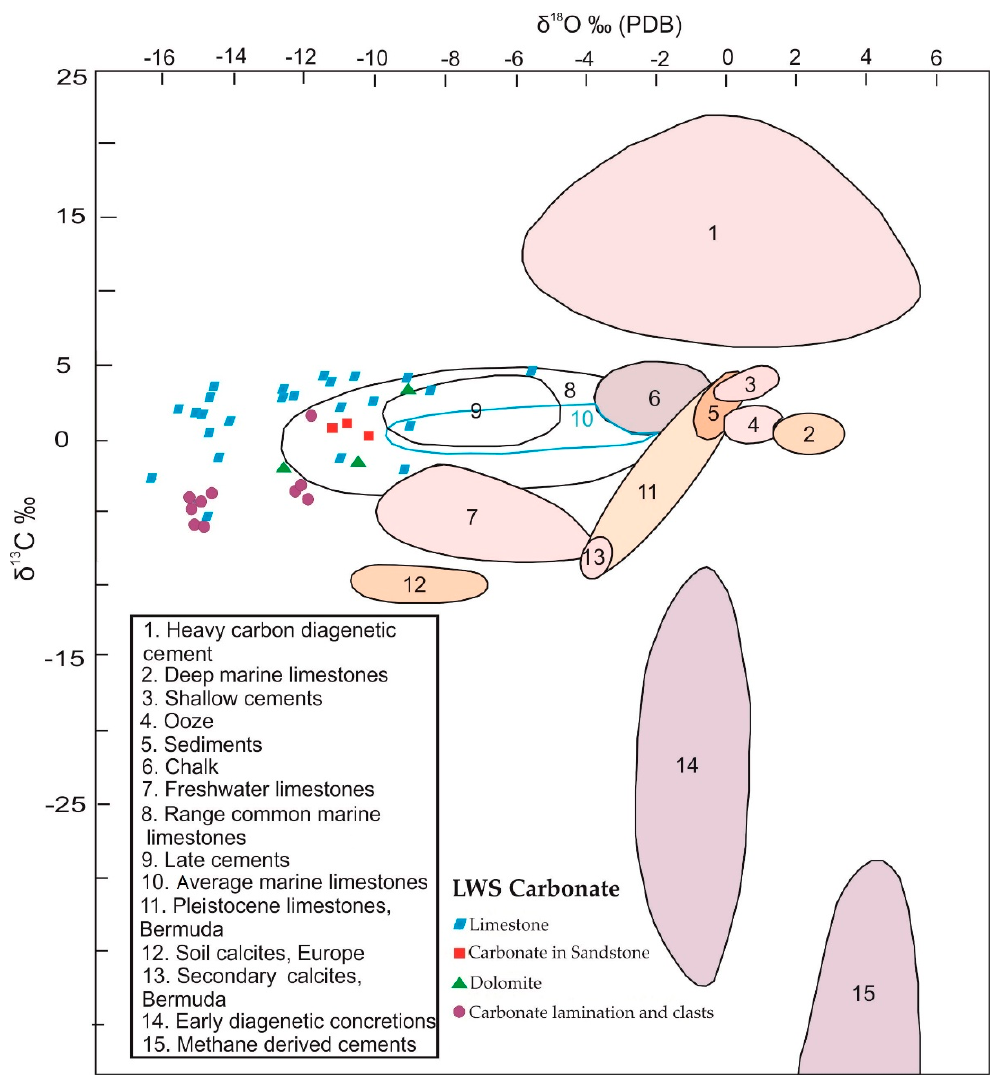
Figure 3. The δ 18 O ‰ (PDB) and δ 13 C ‰ cross-plots of carbonate laminae and clasts within the